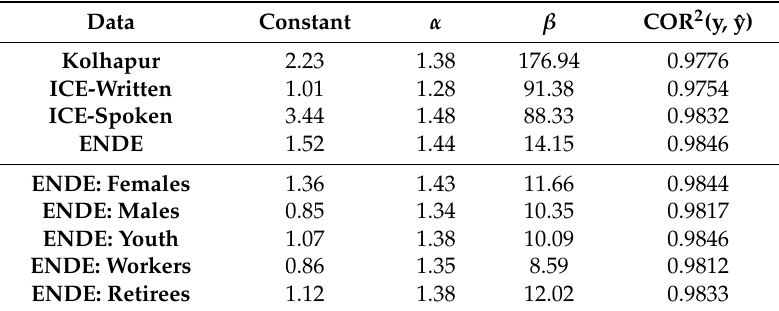
Figure 2. Analyzing ENDE Females and ENDE Males corpora fit to Mandelbrot’s Law. Each row corresponds to those corpora respectively. ( a – c ) as described for Figure 1. For females, we do see a more random scatter of residuals (reflected in the relatively flatter slope to the right of the fitted value of − 5) than for the highest ranked words, suggesting a slightly better model over the one for males. Table 4. Comparing Mandelbrot-derived best fit models across IE